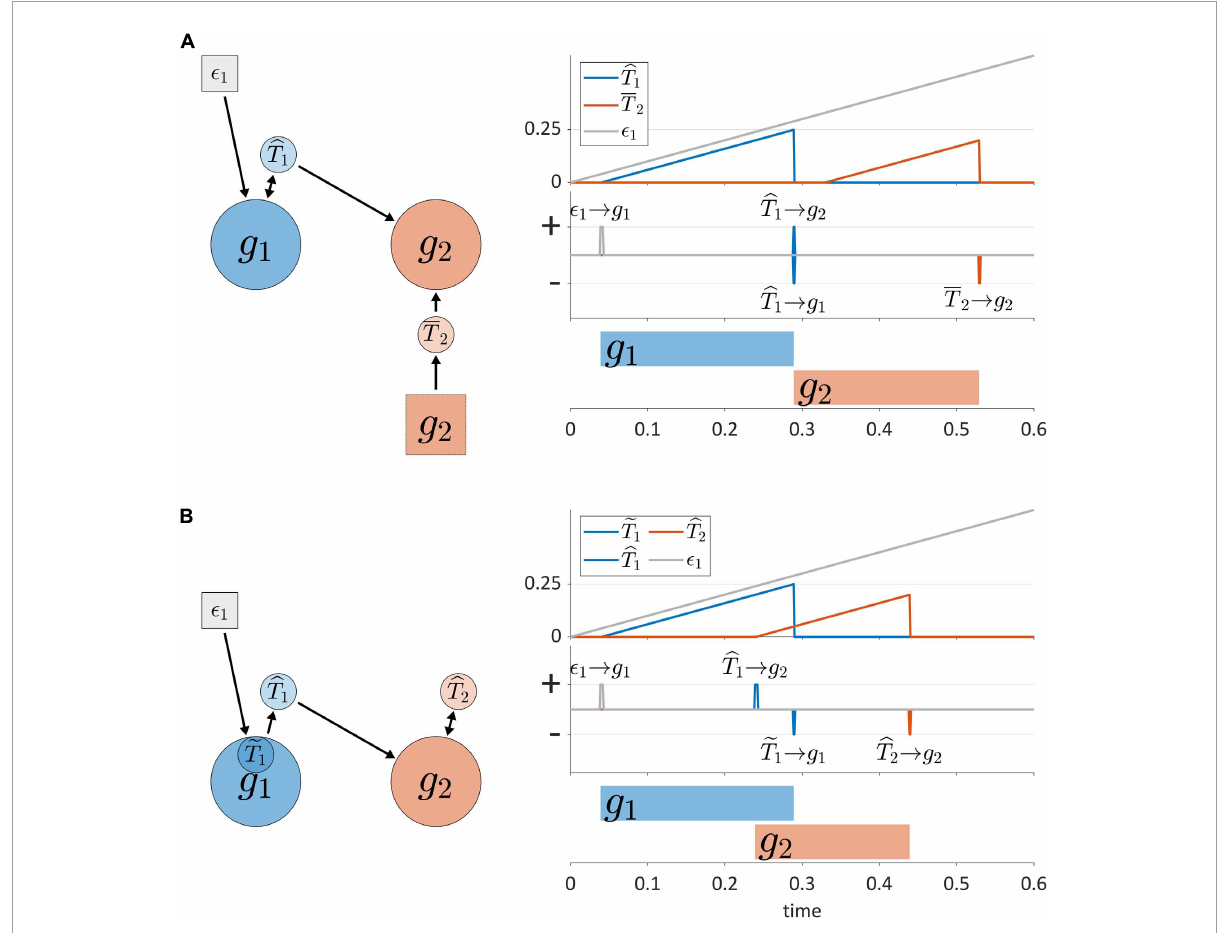
FIGURE6 (A) External vs. internal sources of feedback for non-autonomous TiRs. Panels on the right show timer states, timer actions, and gestural activation intervals. (B) Example of inter-gestural vs. isolated/intra-gestural